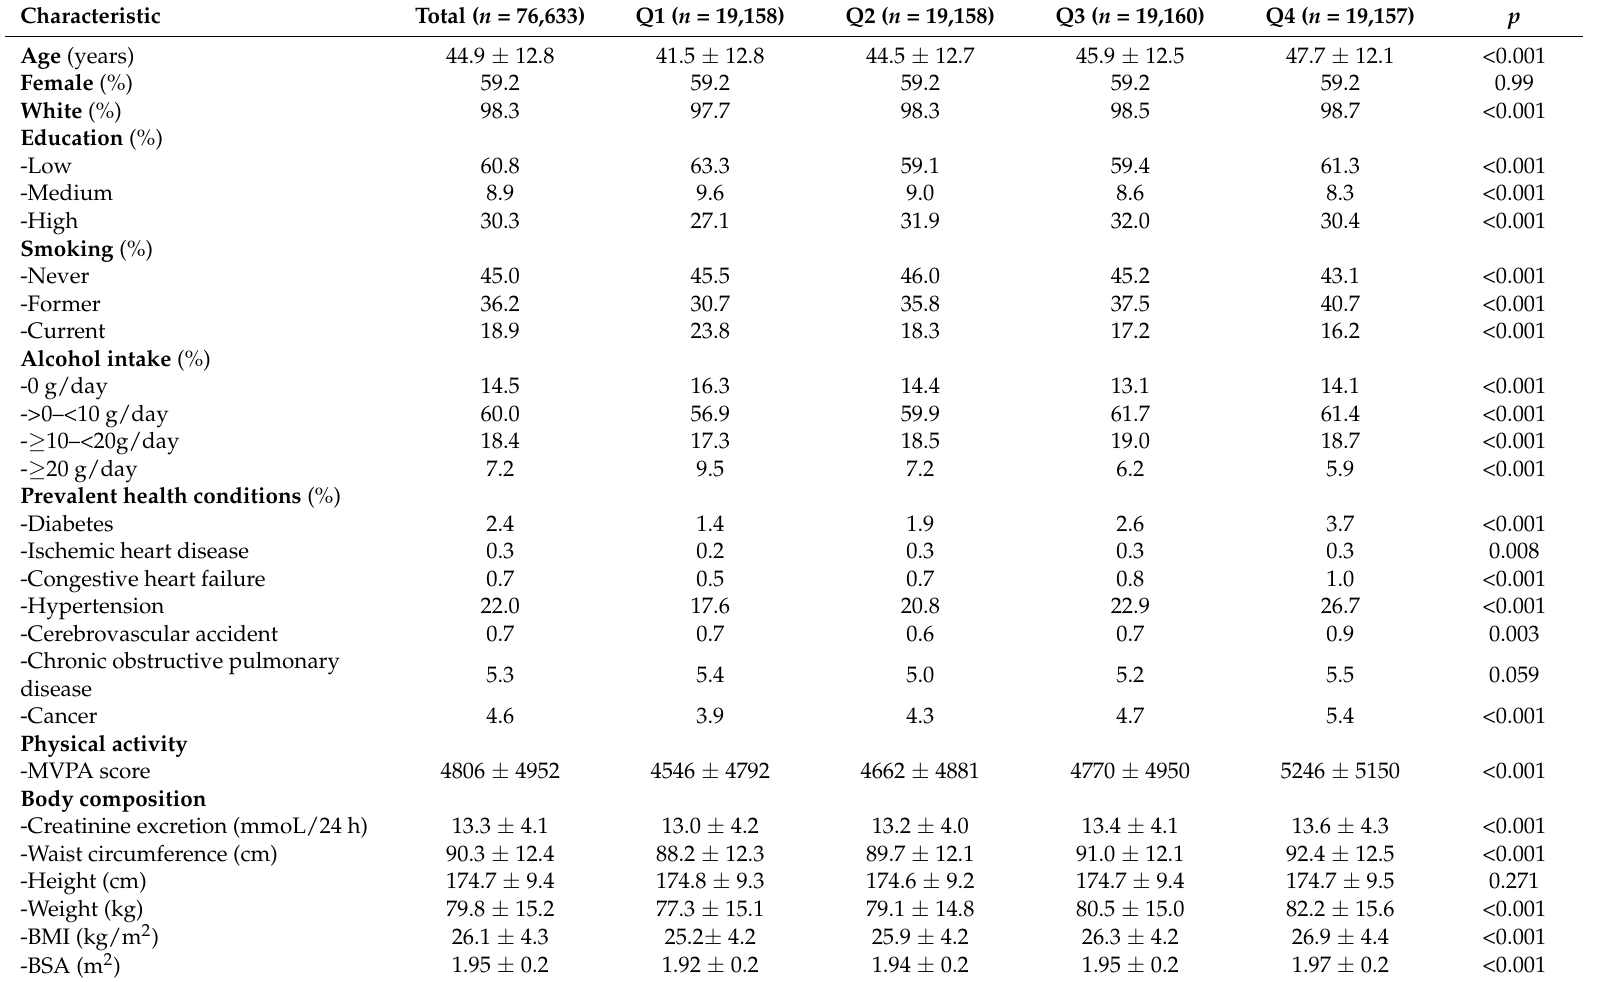
Table 1. Baseline characteristics by sex-stratified quartile (Q) of energy-adjusted total protein intake 1